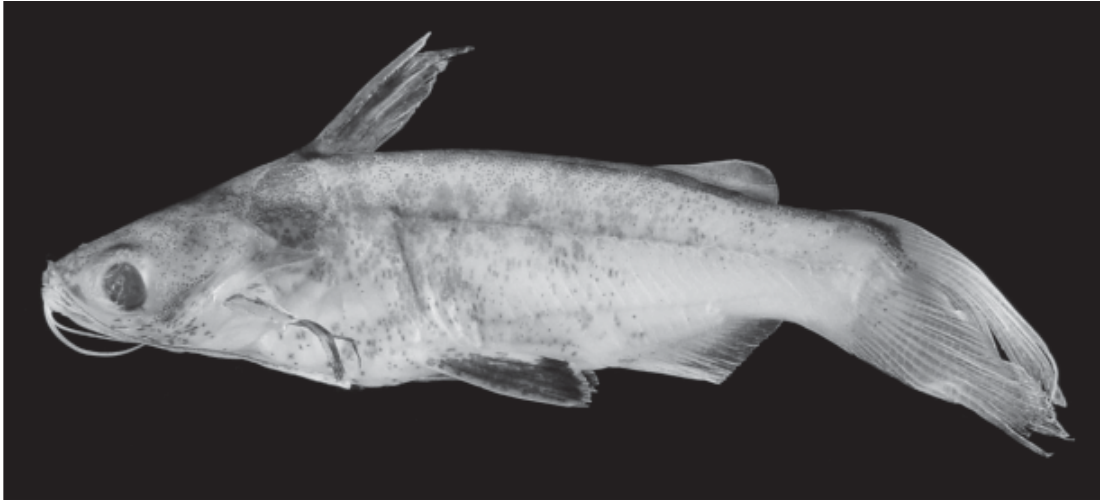
Fig. 2. Entomocorus melaphareus , paratype, MZUSP 76445, 43.1 mm SL.